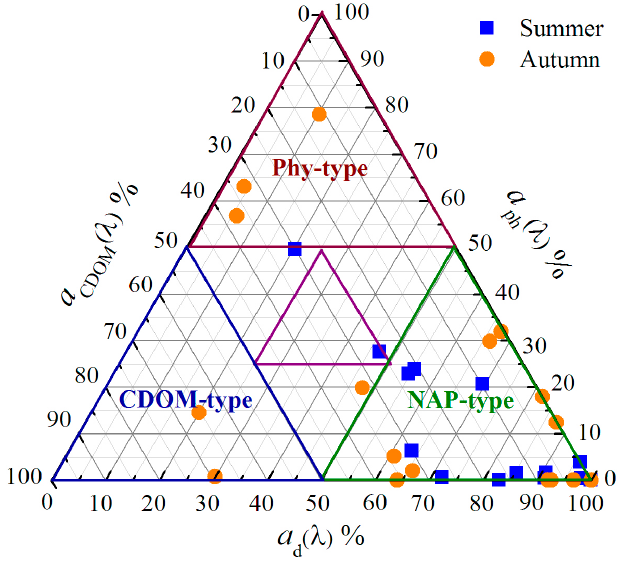
Figure 7. Relative contributions of CDOM, phytoplankton and non ‐ algal particles to total non ‐ water light absorption at 440 nm. According to the optical classification of surface waters (Prieur and Sathyendranath, 1981), the relative contribution of collected water sampling locations could be classified as “CDOM ‐ type”, “non ‐ algal particles type (NAP ‐ type) ʺ and “phytoplankton ‐ type (Phy ‐ type)” due to the variation of water quality parameters.